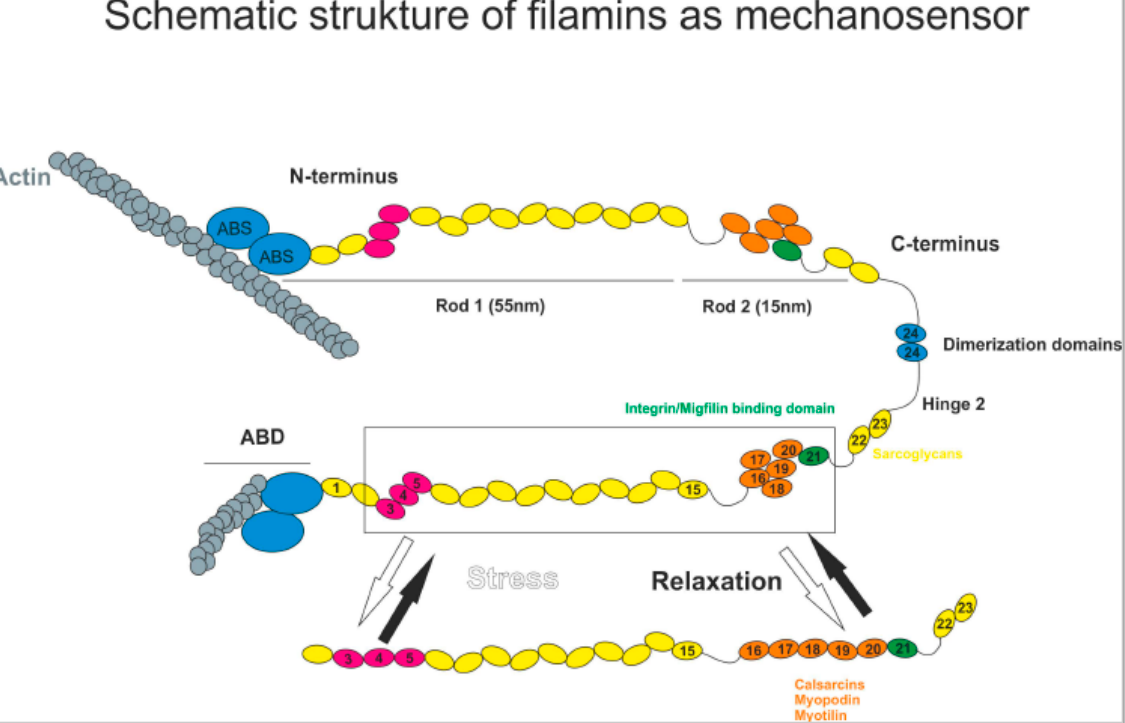
Figure 1. Schematic structure of filamins as